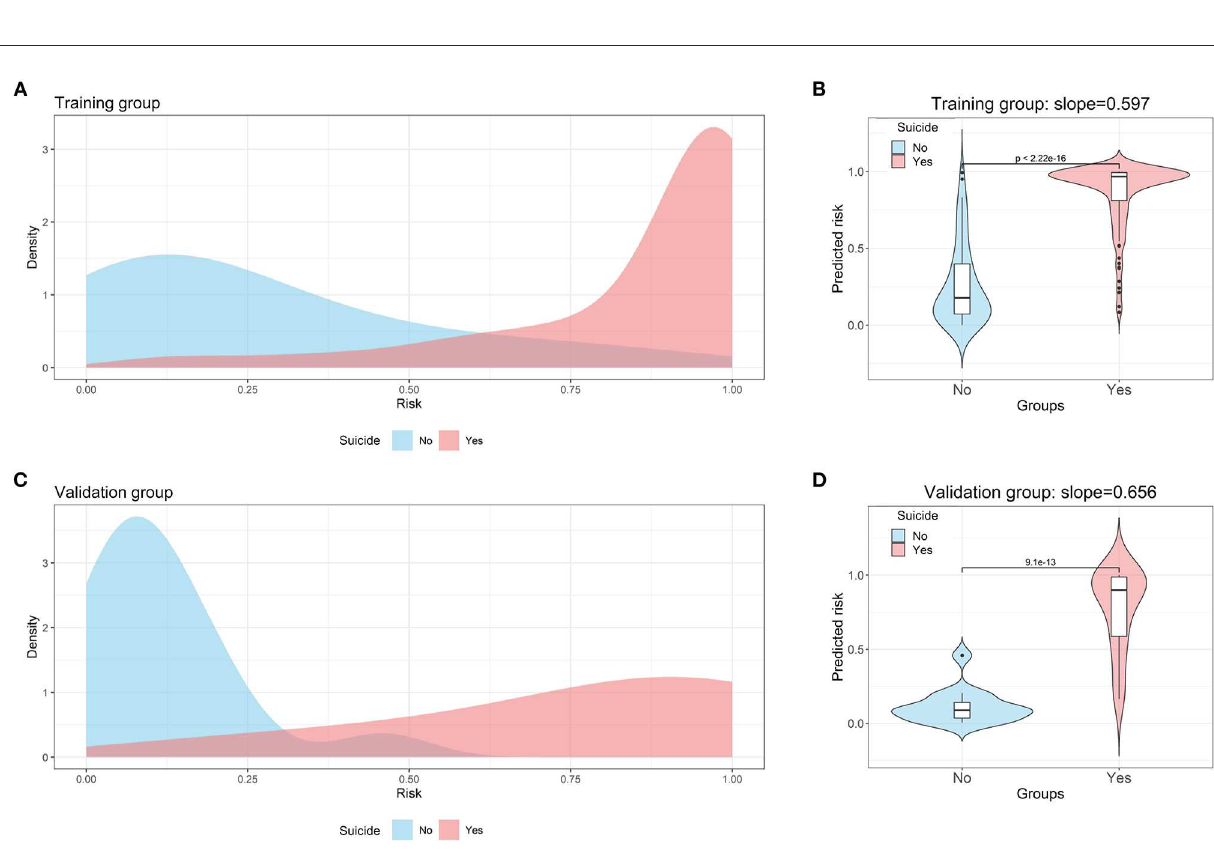
FIGURE4 Probability curve and discrimination slope for the nomogram. (A) Probability curve for the nomogram in the training group. (B) Discrimination slope for the nomogram in the training group. (C) Probability curve for the nomogram in the validation group. (D) Discrimination slope for the nomogram in the validation group. The light blue indicates patients without suicide. The light red indicates patients with self-poisoning. A large separation between patients with and without suicide was observed in both training and validation